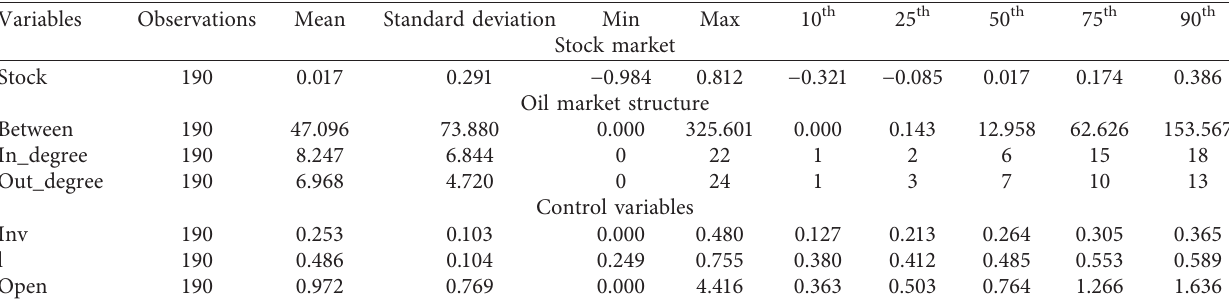
Figure 5: Reciprocity coefficient of the Asian crude oil market network. Source: results calculated from the software STATA 16.0. Table 1: Descriptive statistics of the variables in the